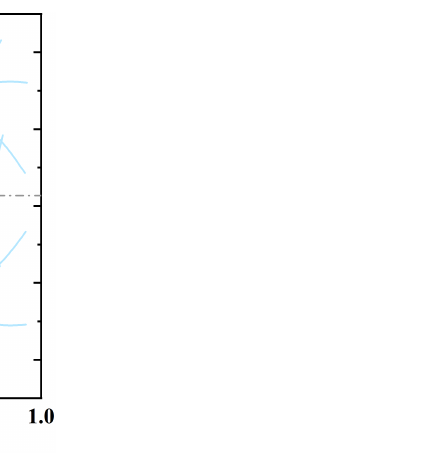
Figure 16. Asymmetry in the shapes (swimming gaits) of the propulsor induced by the strong ground effect at ¯ D = 0.4.